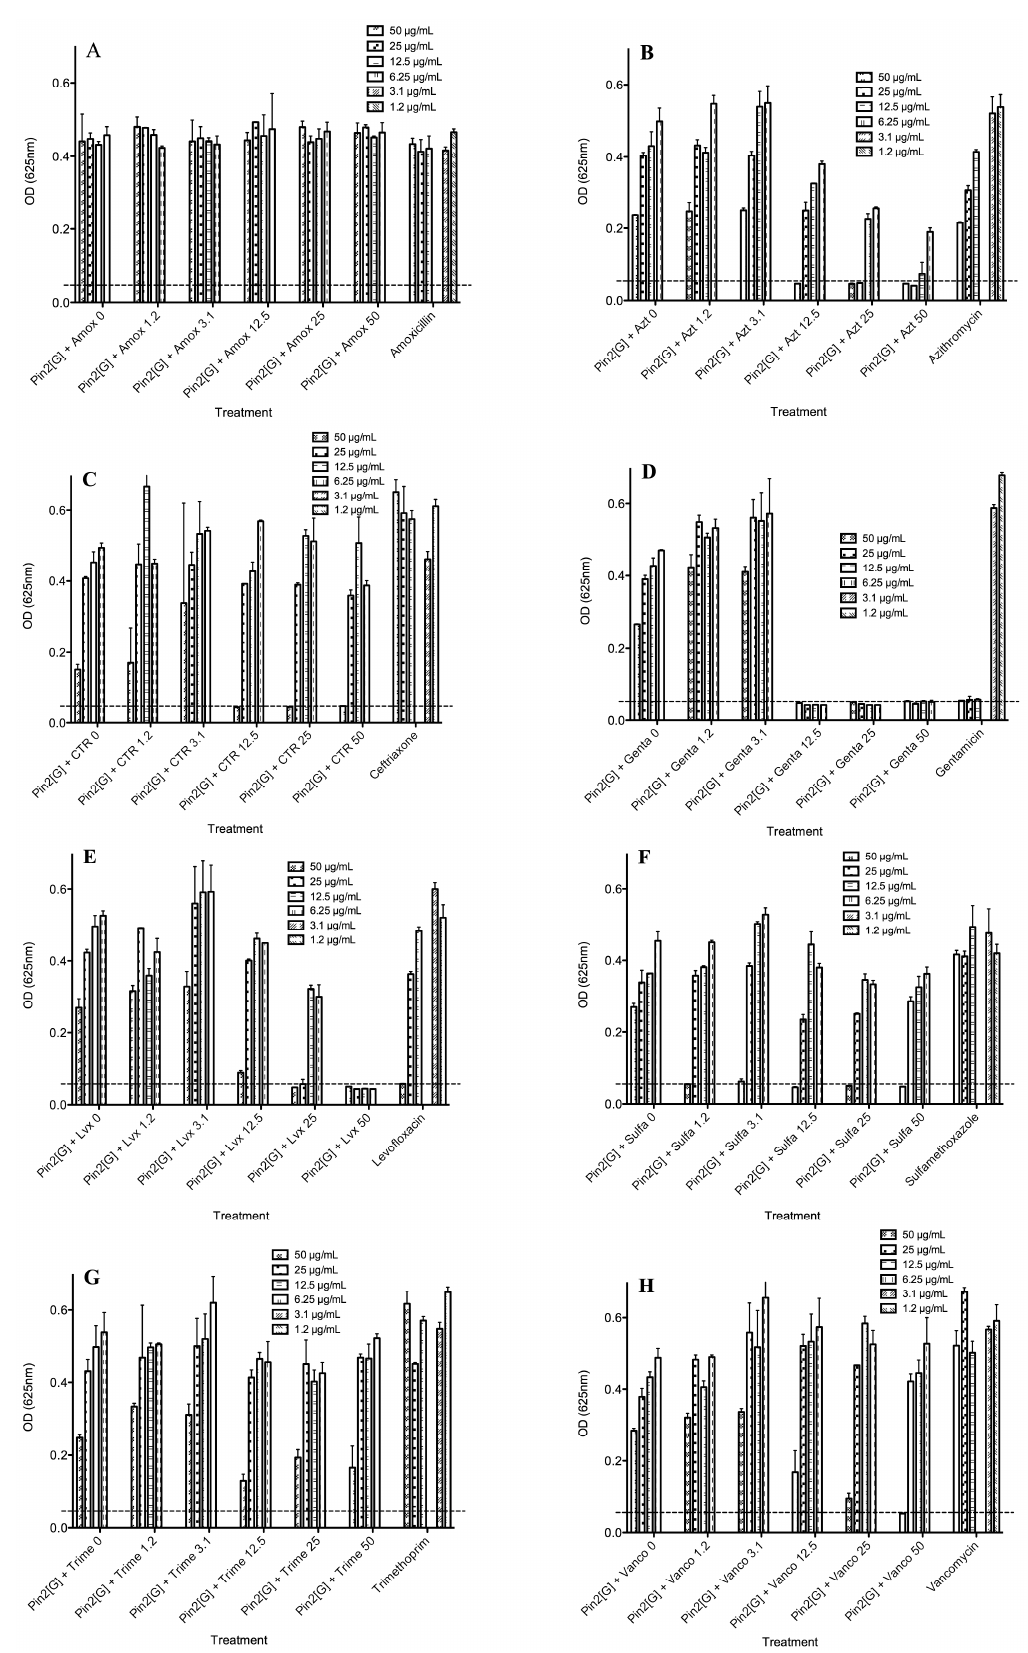
Figure 5. Antimicrobial activity of Pin2[G] in the presence of eight different commercial antibiotics against K. pneumoniae . ( A ) Amoxicillin; ( B ) Azithromycin; ( C ) Ceftriaxone; ( D ) Gentamicin; ( E ) Levofloxacin; ( F ) Sulfamethoxazole; ( G ) Trimethoprim and ( H ) Vancomycin. Bacteria-free well absorbances are indicated by a dotted line.